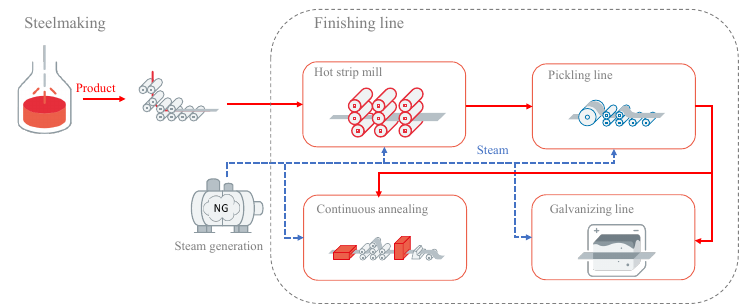
Figure 1. Schematic layout of the considered parts of the steel